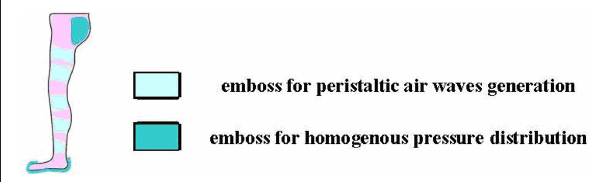
FIGURE 6 | MOD: plantar skin protection and pulsed air flow to mimic the “muscles’ pump”—thus compensating the returning, venous-lymphatic circulation, in the lower limbs—concepts. Reproduced with permission from the publisher (Onose et al., 2012a, pp.